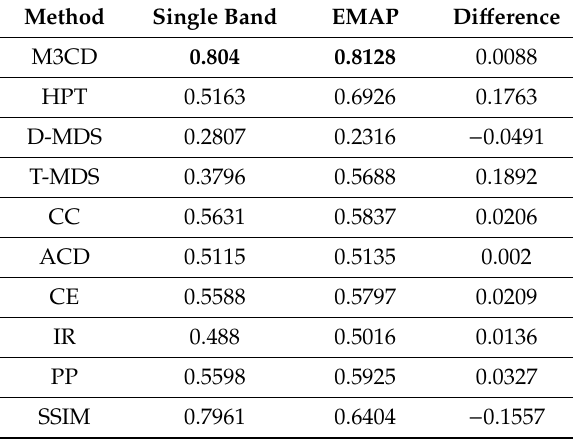
Table 6. AUC values and di ff erences between single band and EMAP cases for dataset-5. Bold numbers indicate the best performing method in each